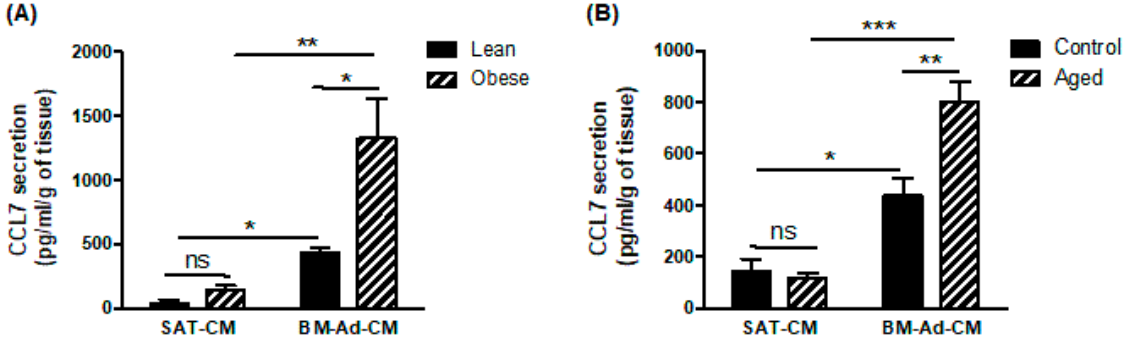
Figure 3. CCL7 is highly secreted by BM-Ads and its secretion is enhanced in obesity and ageing conditions. Secretion of CCL7 was evaluated by ELISA in SAT-CM or BM-Ad-CM either obtained from lean/obese ( A ) or control/aged ( B ) subjects. Data are shown as mean ± sem ( n = 3–5). The statistical significance was evaluated by Two-way ANOVA with Tukey's multiple comparisons test. * p < 0.05, ** p < 0.01, *** p < 0.001, ns: not significant.